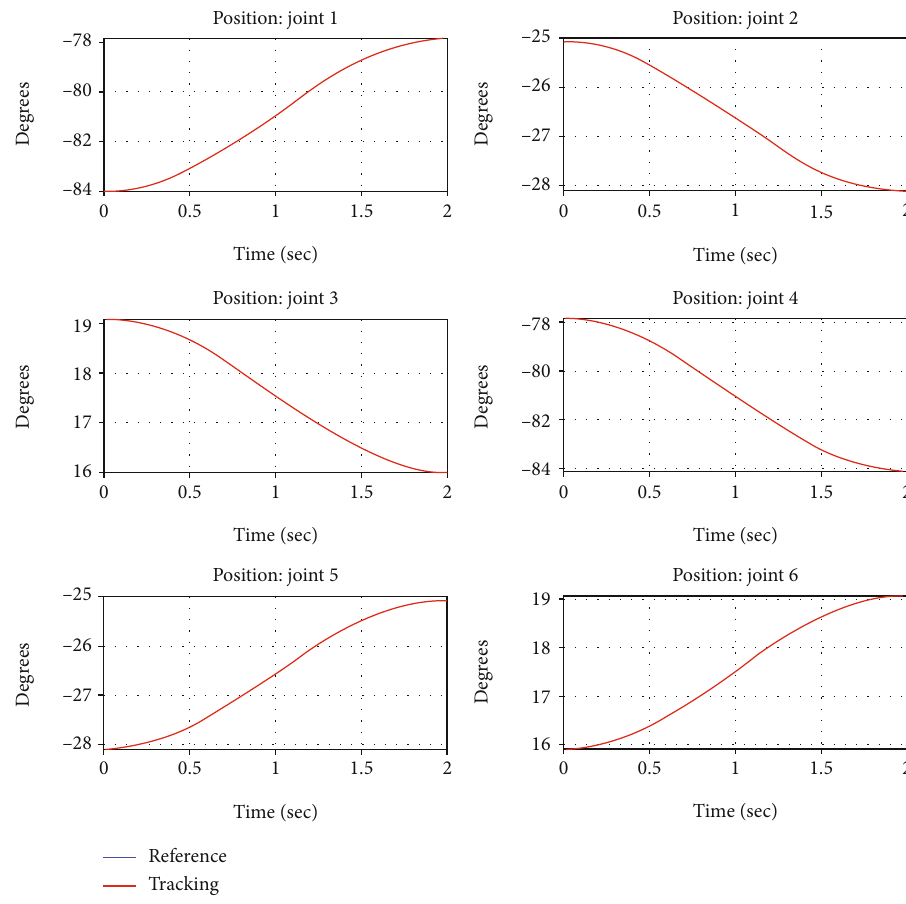
Figure 3: Tracking of the reference